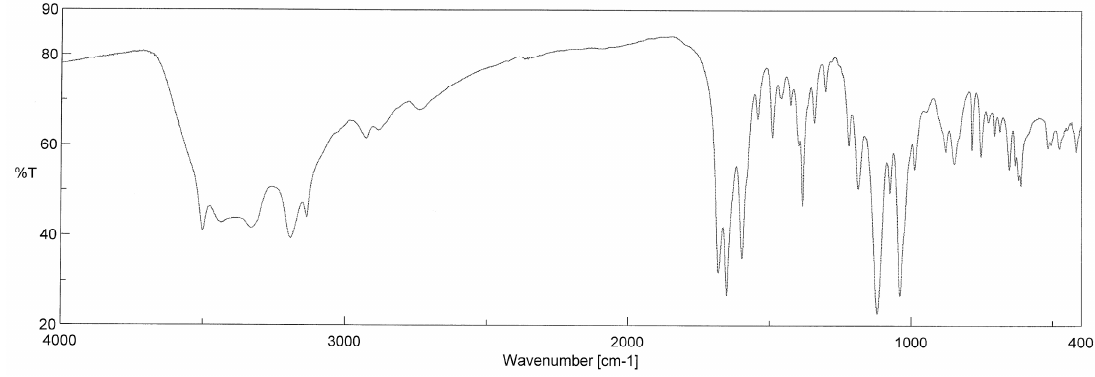
Figure A6. FT-IR spectrum of compound 1 . Table A5. Assignation peaks of compound 1 .